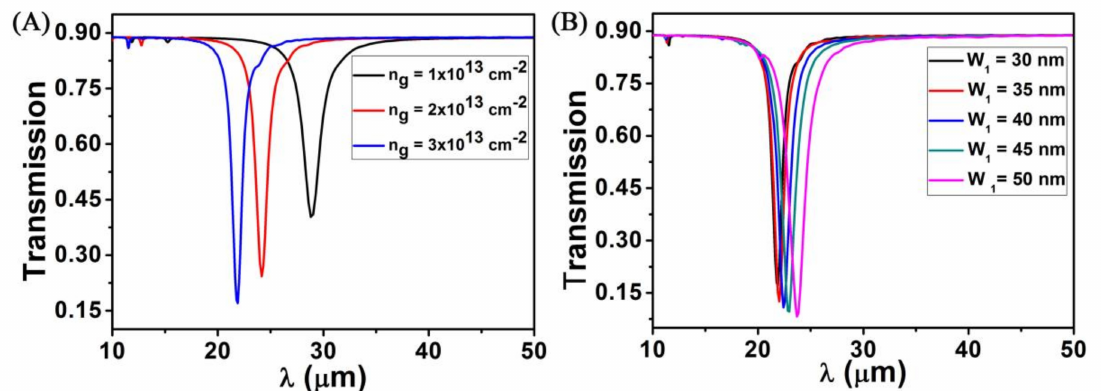
Figure 5. ( A ) Calculated the transmission spectra at different doping levels ( n g ); ( B ) Calculated transmission spectra at different ring width ( W 1 ). Other geometry parameters are set to L = 180 nm, W 2 = 30 nm, P = 300 nm, and n med = 1.0.